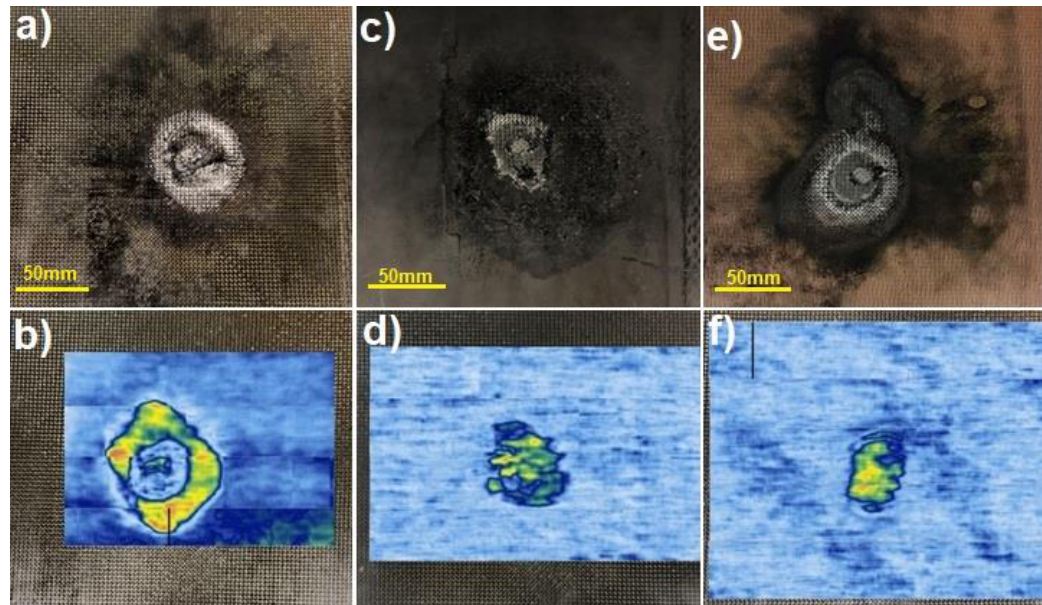
Figure 12. Images of composites flat panels after a lightning strike (upper row) and ultrasonic C-Scan visualization (lower row) for: ( a , b ) L_ref, ( c , d ) L_TP and ( e , f ) L_ECF. row) for: ( a , b ) L_ref, ( c , d ) L_TP and ( e , f )